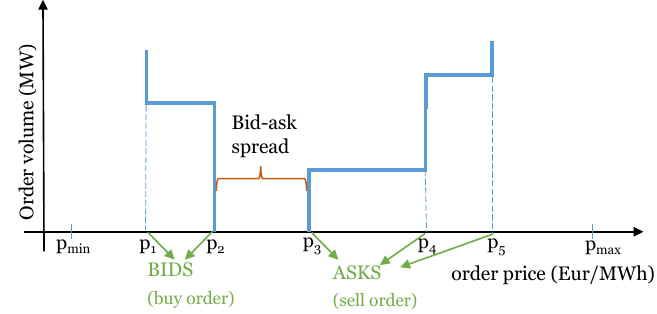
Figure 2. Graphical representation of the shared order book at time t